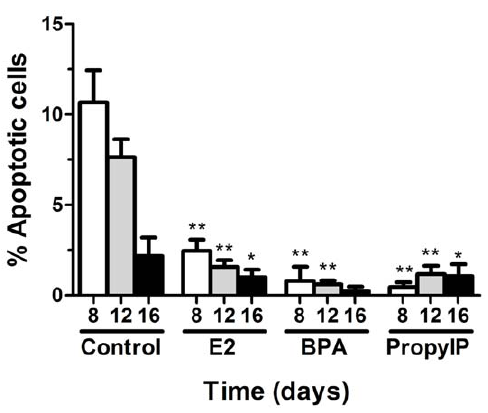
Figure 6. Quantification of the percentage of apoptotic cells per acini. The percentage of apoptotic cells was calculated for 8, 12 and 16 days incubation periods. This was determined as the number of cells positive to activated caspase-3 (stained green) over the total number of cells in each acini. Data corresponds to mean 6 SEM from three independent experiments (10 acini/experiment were analysed). * (p , 0.05) and ** (p , 0.01) denote significant differences between treatment and controls at the corresponding incubation periods.